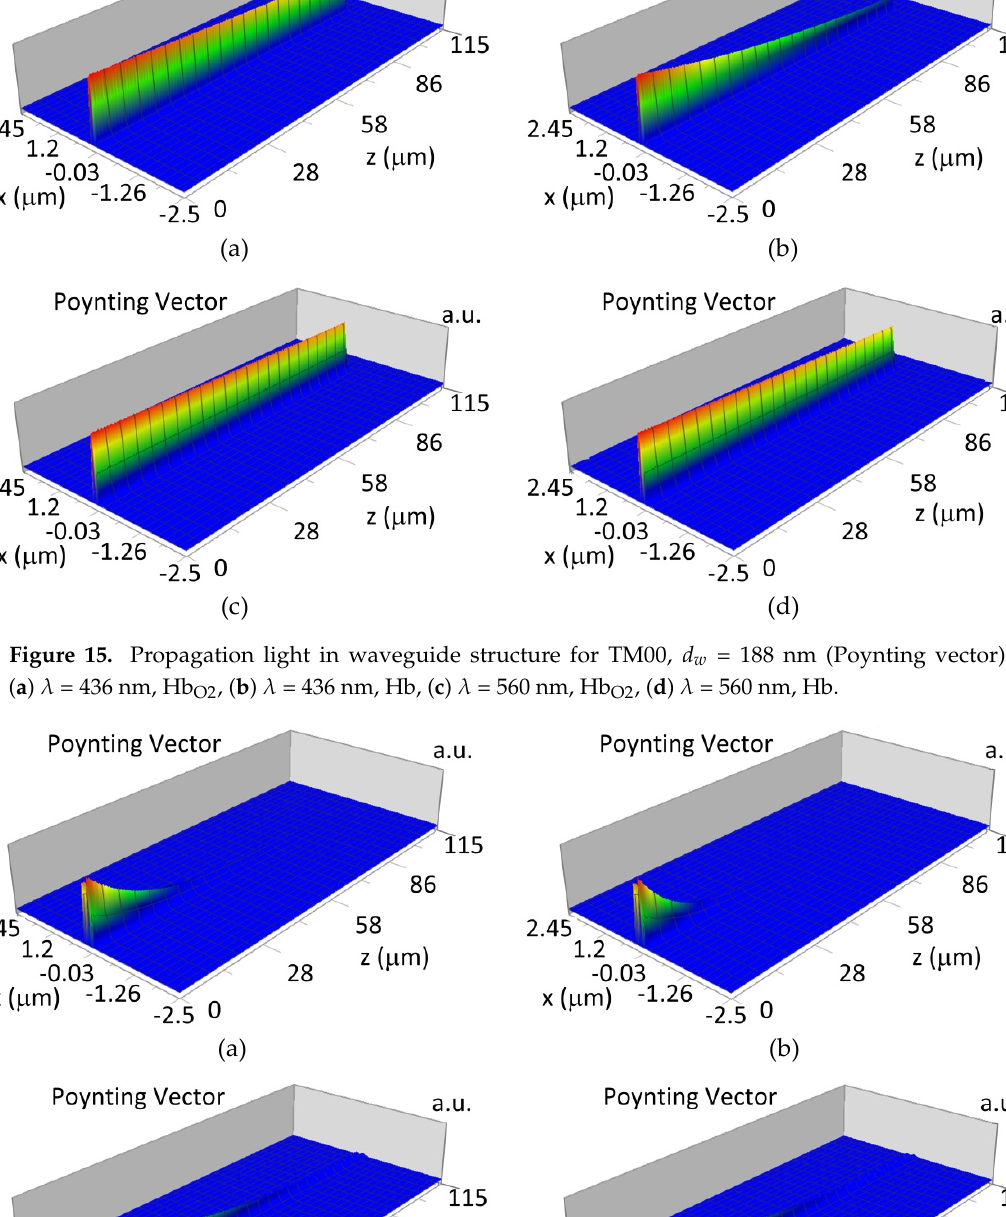
(Poynting vector): ( a ) TE00, Hb O2 , ( b ) TE00, Hb, ( c ) TE01, Hb O2 , ( d ) TE01, Hb.